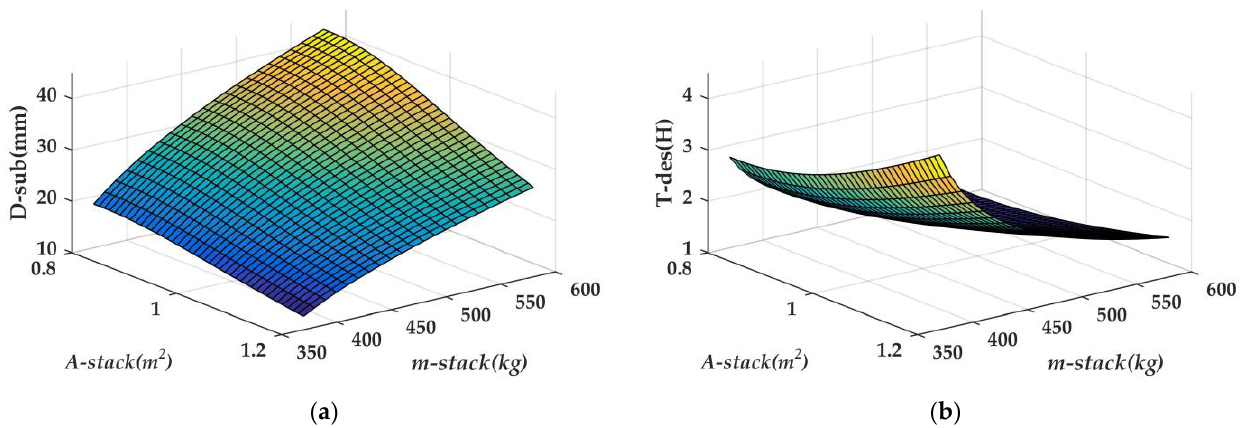
Figure 5. ( a ) Subsidence depth vs. the mass of the weight stack and bottom area of the weight stack; ( b ) descent time vs. mass of the weight stack and bottom area of the weight stack.